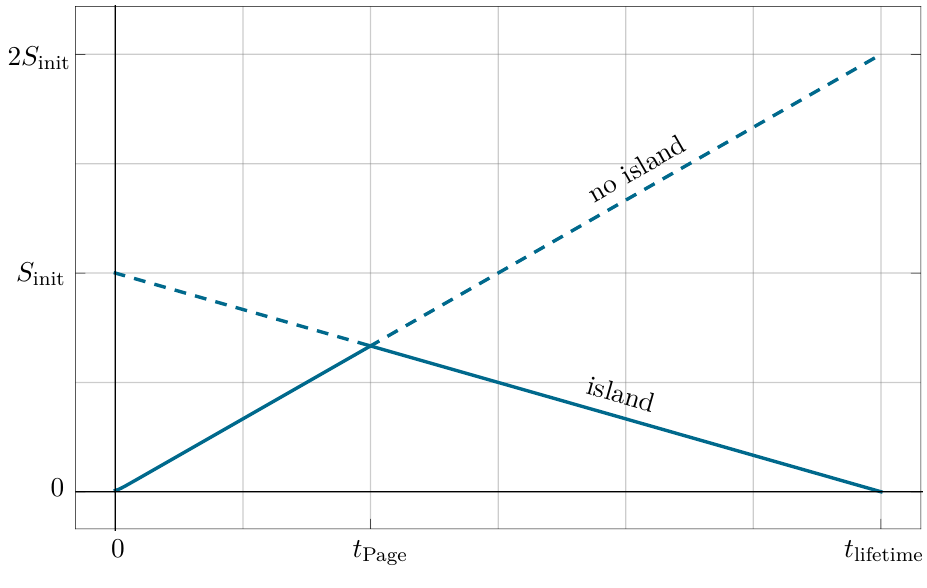
Figure 1 . Page curve for an evaporating RST black